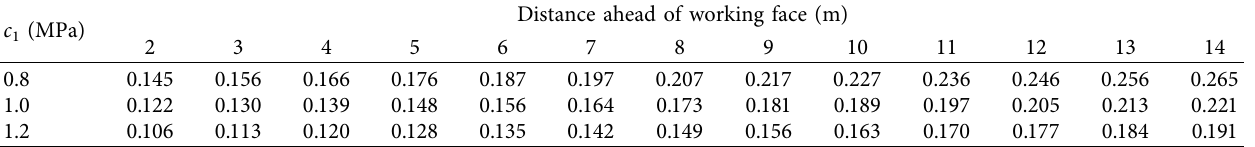
Table 4: The fracture radii R f at various points ahead of the working face (m).